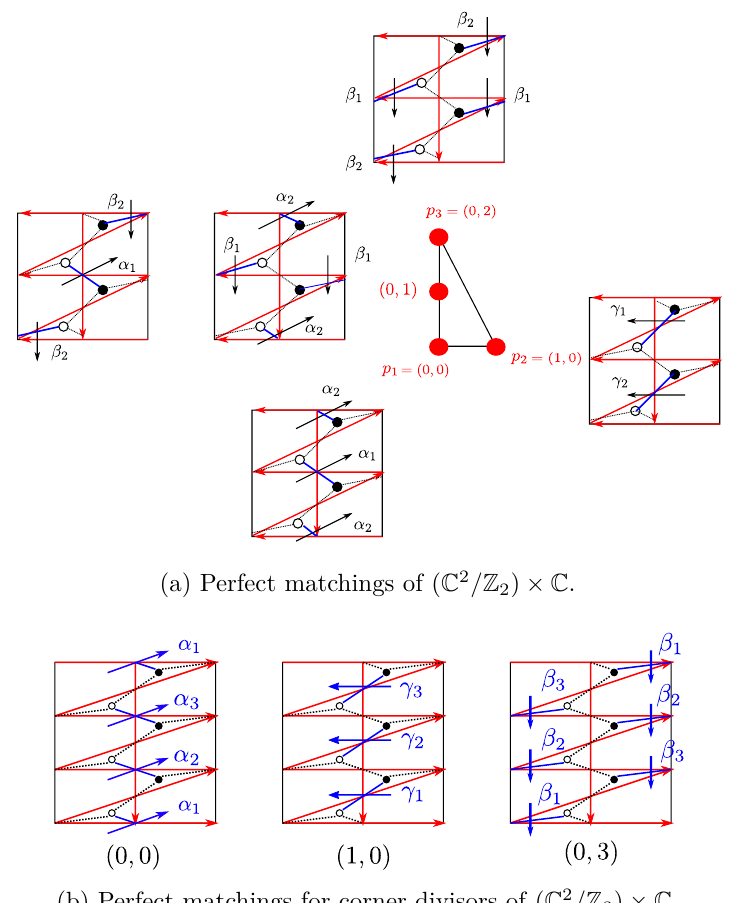
Figure 28. Perfect matchings of divisors of C 2 / Z n × C ( n ≥ 2) . (a) For the n = 2 case,